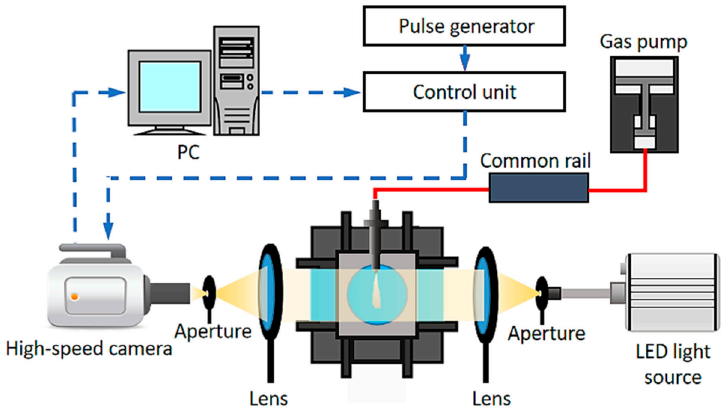
Figure 3. The schlieren imaging test